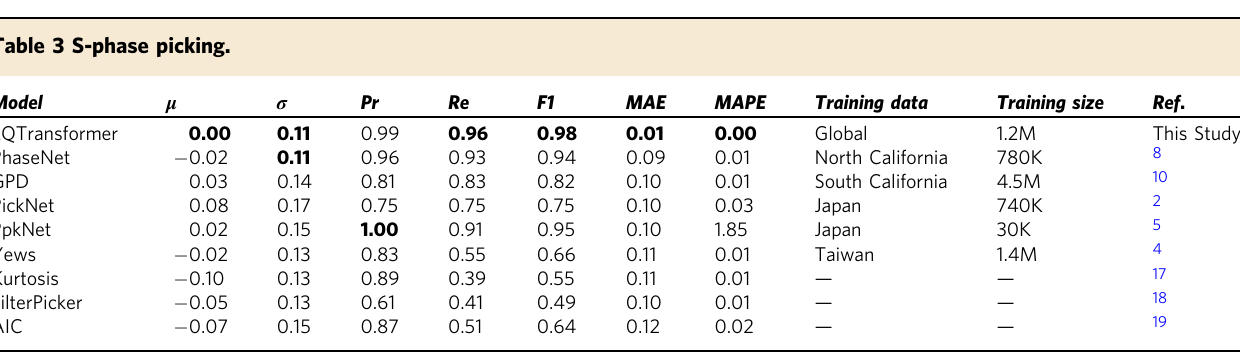
Table 3 S-phase